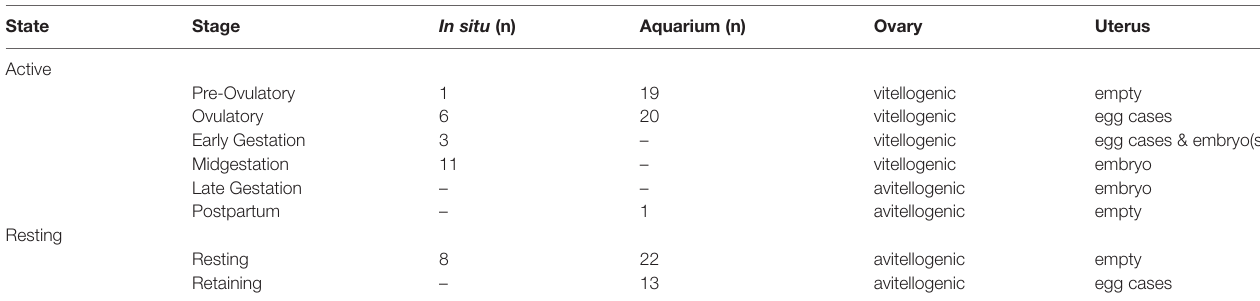
TABLE 4 | Sand tiger shark Carcharias taurus reproductive stages.